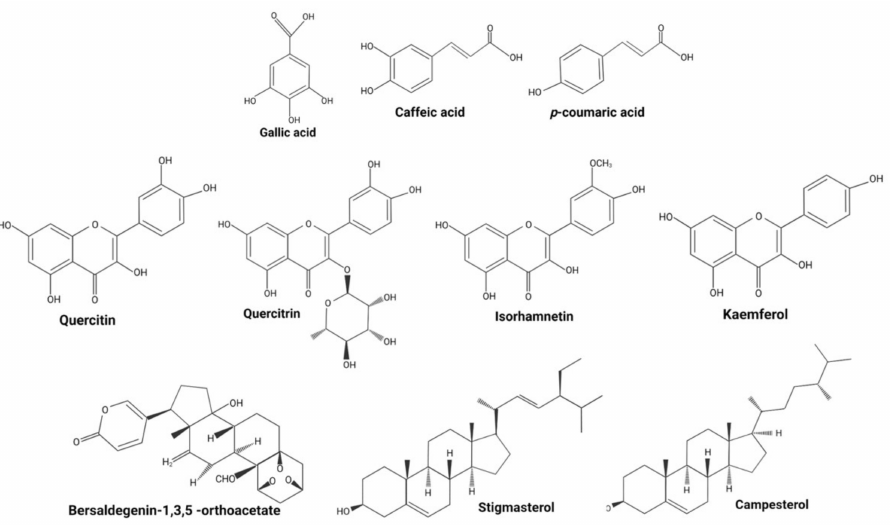
Figure 2. Structures of major phytochemicals reported in K. pinnata . Source: Image created with